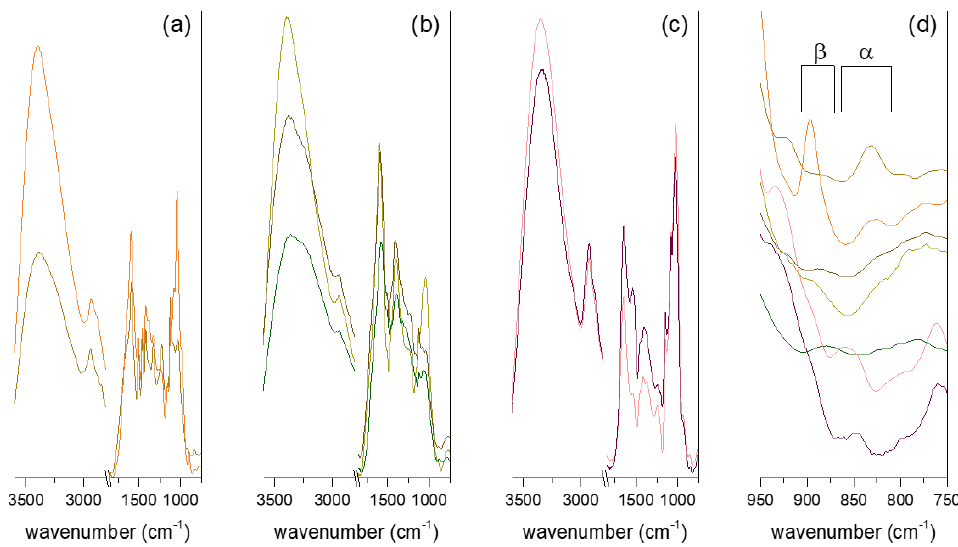
Figure 2. ATR-FT-IR spectra of the polysaccharide fractions. The fractions reported, from top to bottom, are, respectively, ( a ) Heart Rot 2% and Heart Rot HW; ( b ) F-Chaga HW, C-Chaga HW, and F-Chaga 2%; ( c ) IPSsb0–2.5 HW and IPSsb0–2.5 2%. The anomeric region of the stacked spectra is expanded in ( d ). The fractions reported, from top to bottom, are, respectively, Heart Rot HW, Heart Rot 2%, C-Chaga HW, F-Chaga HW, F-Chaga 2%, IPSsb0-2.5 HW, and IPSsb0-2.5 2%.